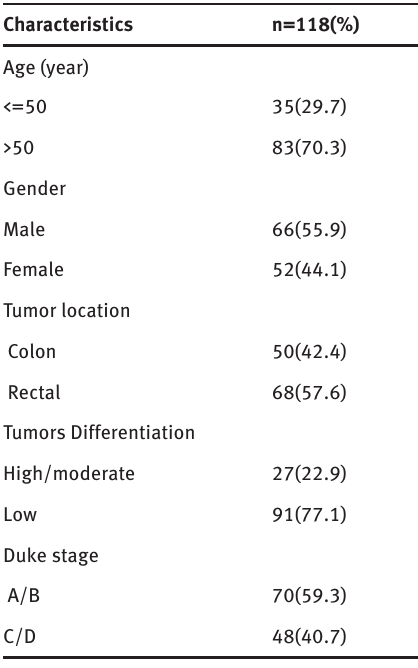
Table 1: The main features of the include 118 CRC patients.